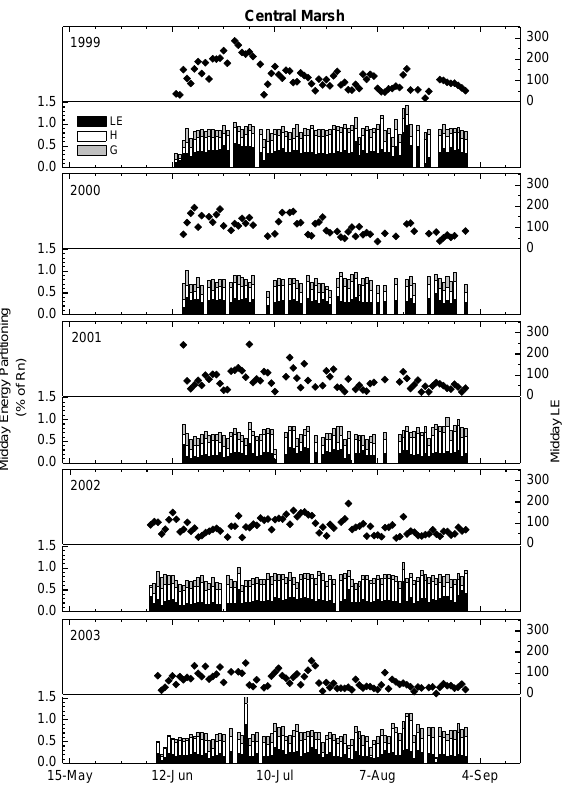
Fig. 3a. The variation in the mean midday energy balance partition- ing and evapotranspiration rates during summer 1999–2003 at the Central Marsh site.